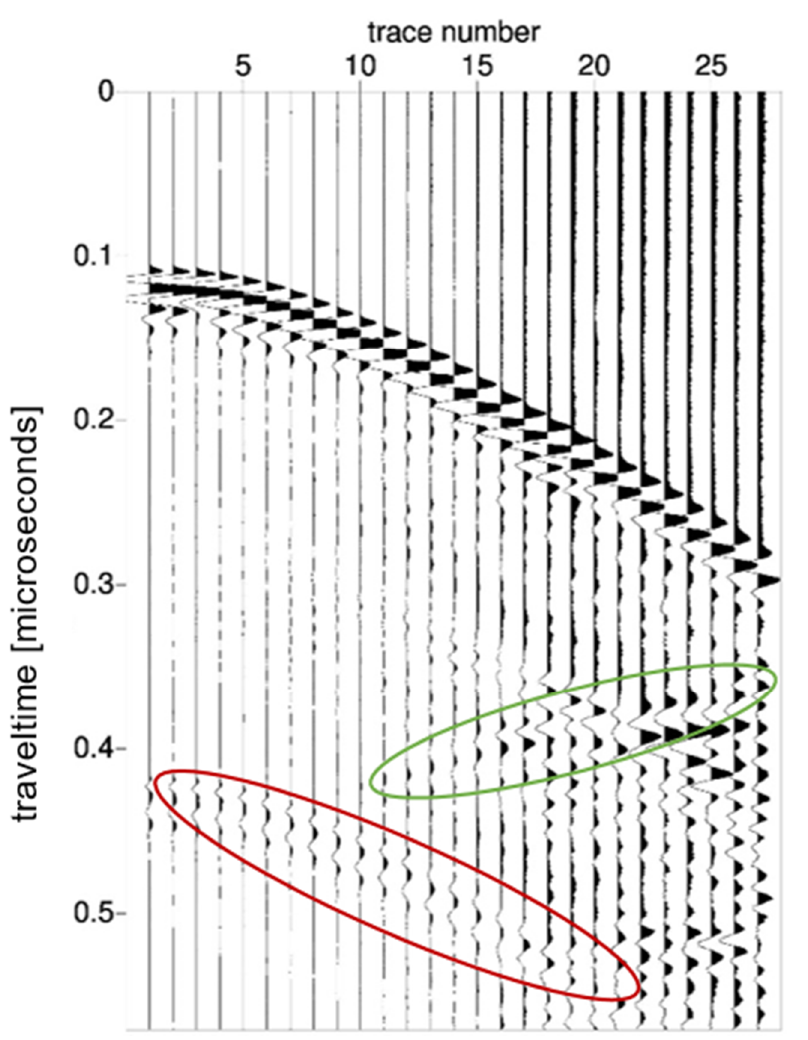
Figure 2. First shot gather of borehole pair 2 and 3. The receiver position is at 2 m borehole depth; the transmitter position varies from 2 to 28 m in depth. See text for explanation of the marked areas.